Question: What form of chart is displayed?
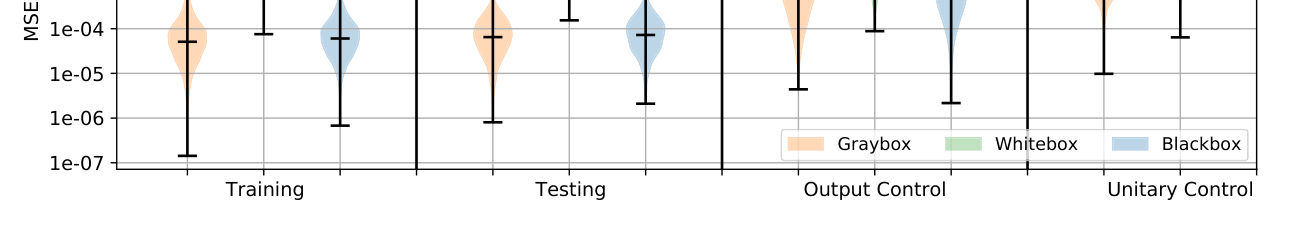
Answer: box